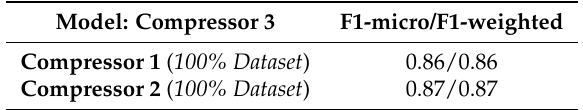
Table 5. Performance of 1D CNN with test datasets from compressors 1 and